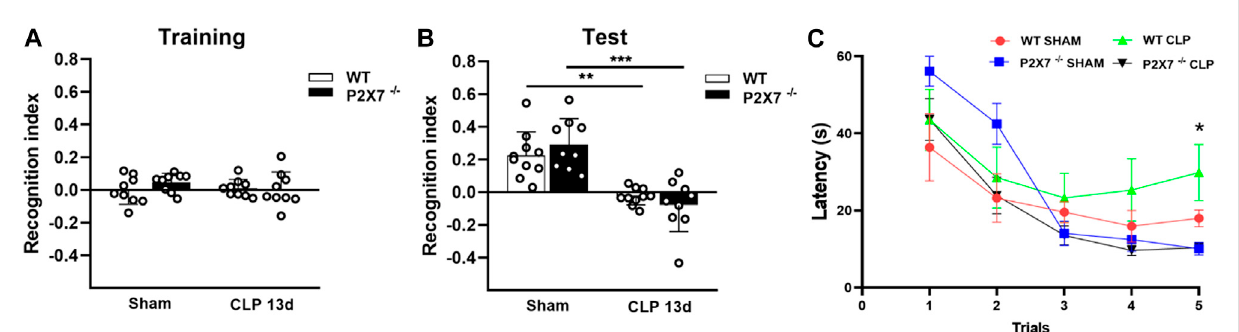
FIGURE 1 P2X7 receptor contributes to spatial working memory impairment in sepsis-surviving mice 13 days after surgery. Recognition index in the Novel objectrecognitiontest(NORT)forCLP(WTandP2X7 − / − )andshamanimalsduringthetrainingwithfamiliarobjects (A) andduringthetestwithfamiliarand novel objects (B) . CLP (WT and P2X7 − / − ) and sham mice were subjected to the Water T-maze test (WTMT) (C) 13 days post-surgery (* WT CLP vs. P2X7 − / − CLP, WT Sham, P2X7 − / − Sham). Data are expressed as mean ± SEM; One-way ANOVA followed by Tukey ’ s post hoc for recognition index and Two- way ANOVA followed by Tukey ’ s post hoc for WTMT. Asterisks represent statistical differences between groups (* p < 0.05; ** p < 0.005; *** p = 0.0001). ( n =9 – 10).Therecognitionindexwascalculatedbysubtractingthetimeexploringthefamiliarobjectfromthetimeexploringthenovelobject,dividedby the total exploration